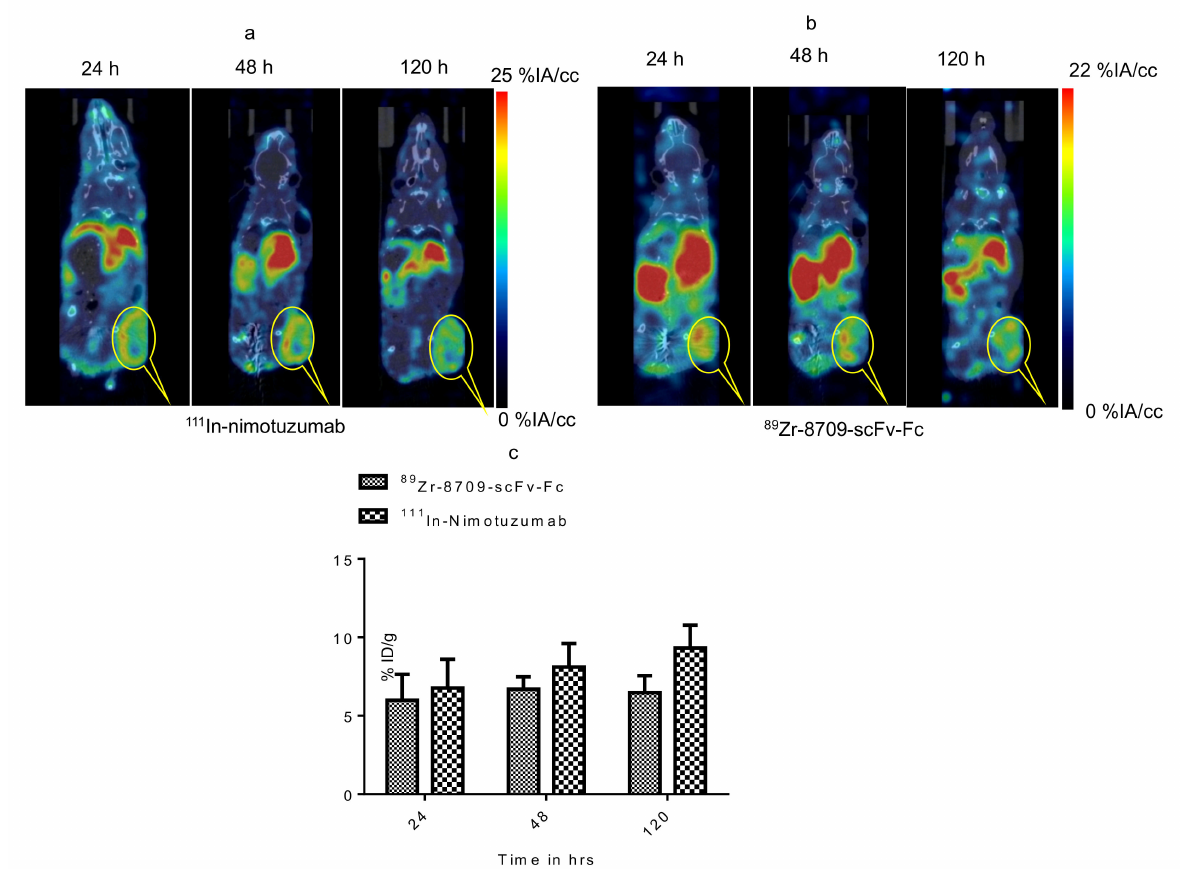
Figure 6. Simultaneous dual tracer ( 111 In-nimotuzumab and 89 Zr-8709-scFv-Fc) imaging of EGFR domain III and domain II in athymic CD-1 nude mice bearing DLD-1 xenograft. ( a ) 111 In-nimotuzumab window, ( b ) 89 Zr-8709-scFv-Fc window and ( c ). Bar graph representing the tumor uptake for 89 Zr-8709-scFv-Fc window and 111 In-nimotuzumab